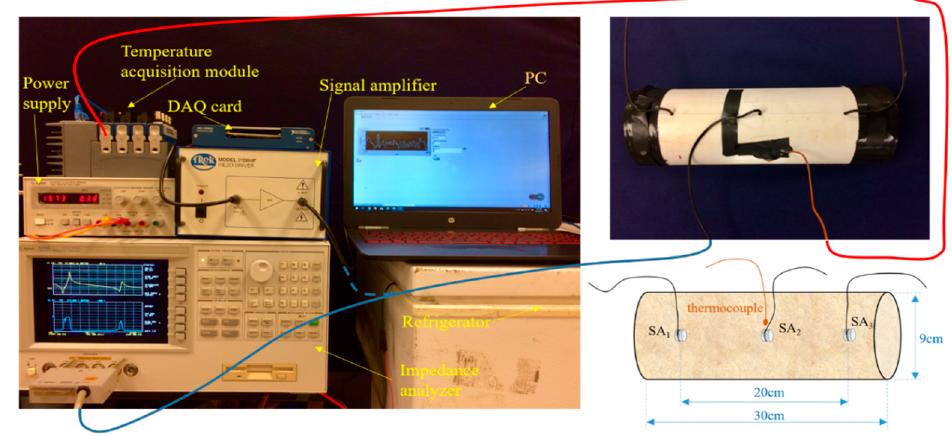
Figure 3. Experimental setup.